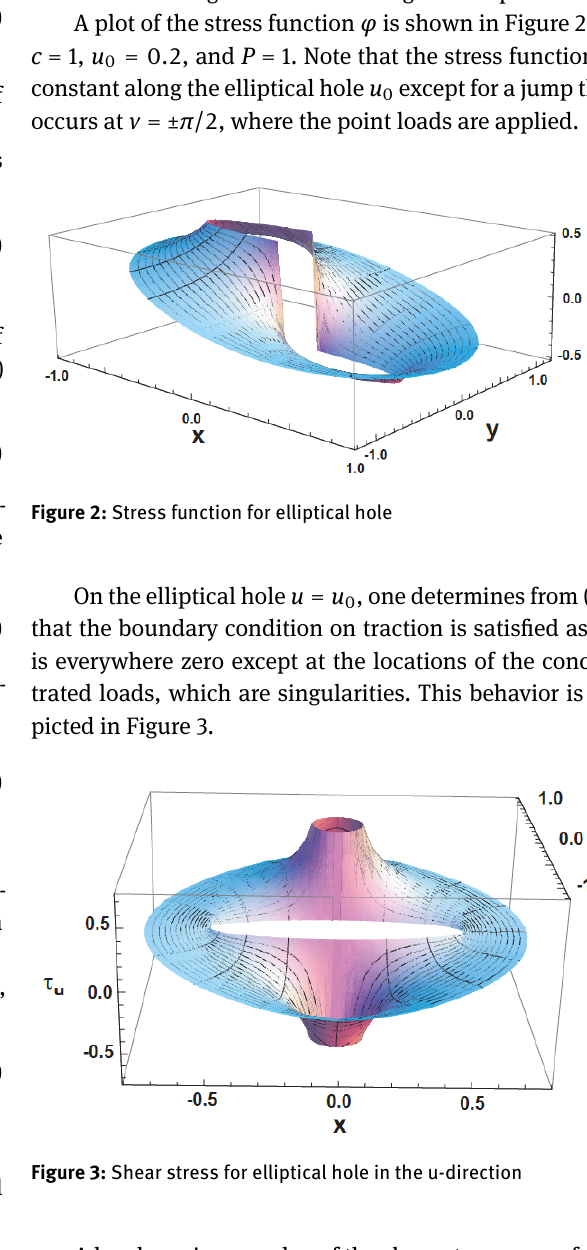
A local maximum value of the shear stress, away from the point loads, is consistent with the value determined previously in